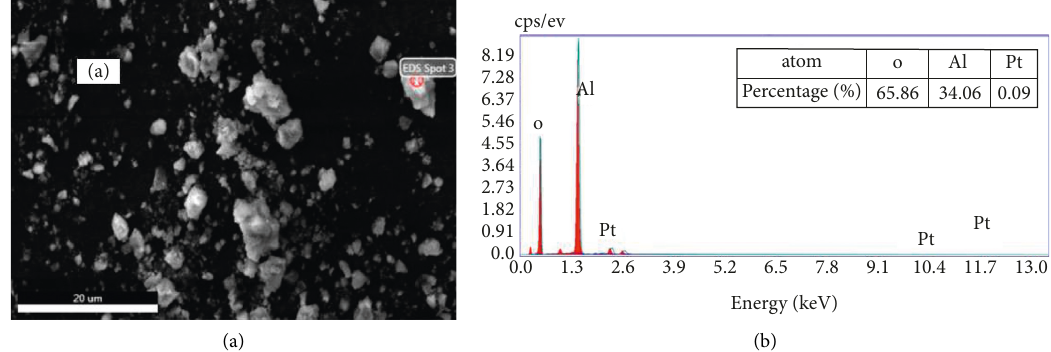
Figure 2: (a) SEM image and (b) EDS spectrum of spent Al